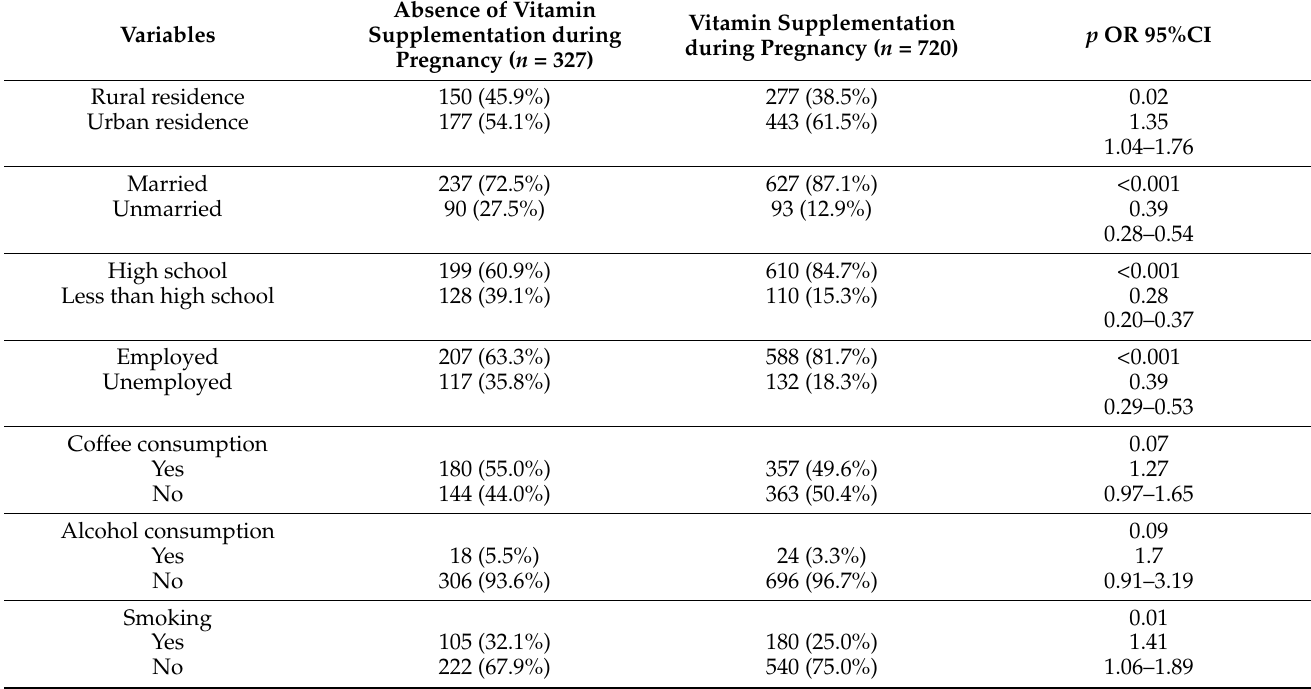
Table 5. Vitamin supplementation during pregnancy as related to socio-economic status and behav- ioral factors with potential